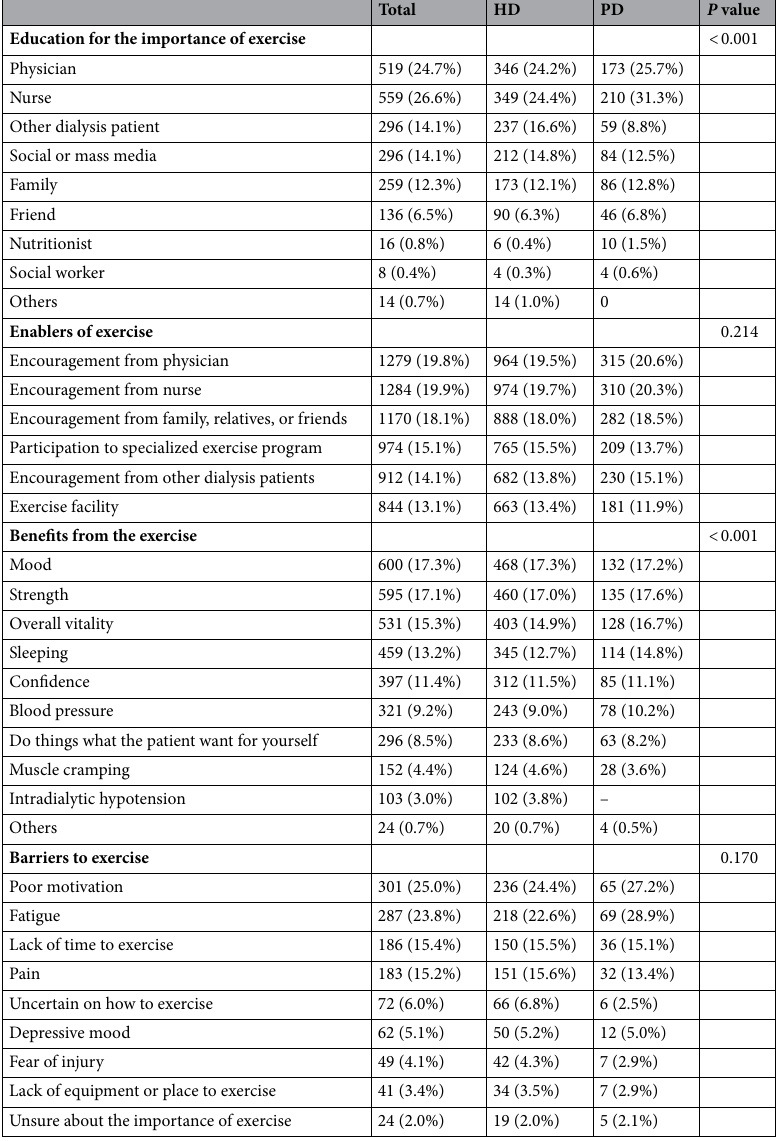
Table 2. Comparison of exercise-related questionnaires according to dialysis modality. Data are expressed as numbers (%). P values were tested using Pearson’s χ 2 or Fisher’s exact